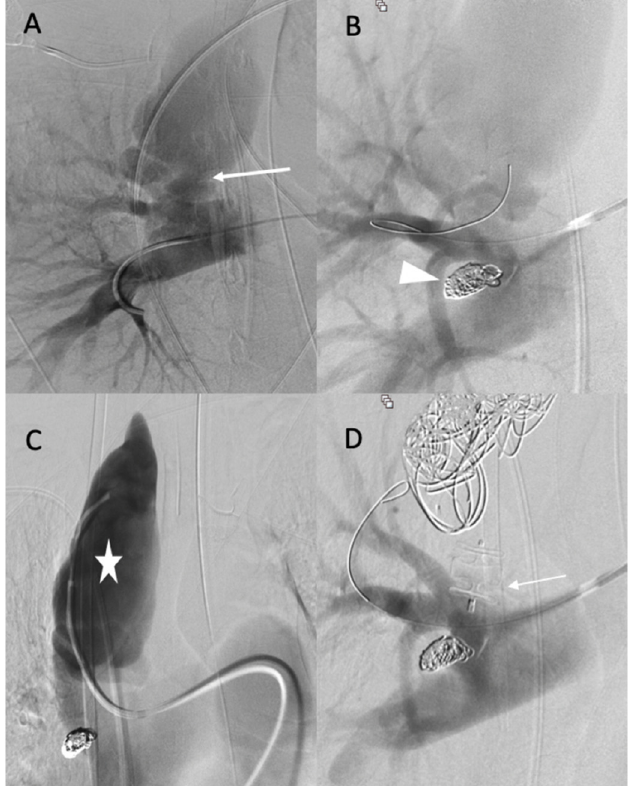
Figure 2. ( A , B ) Before and after the occlusion of the distal portion of the arteriovenous fistula (arrow, head arrow). ( C ) Before the occlusion of pseudoaneurysm (star). ( D ) The occlusion of the proximal portion using first- and second-generation plugs (arrow), and the occlusion of the pseudoaneurysm using multiple 3D coils.